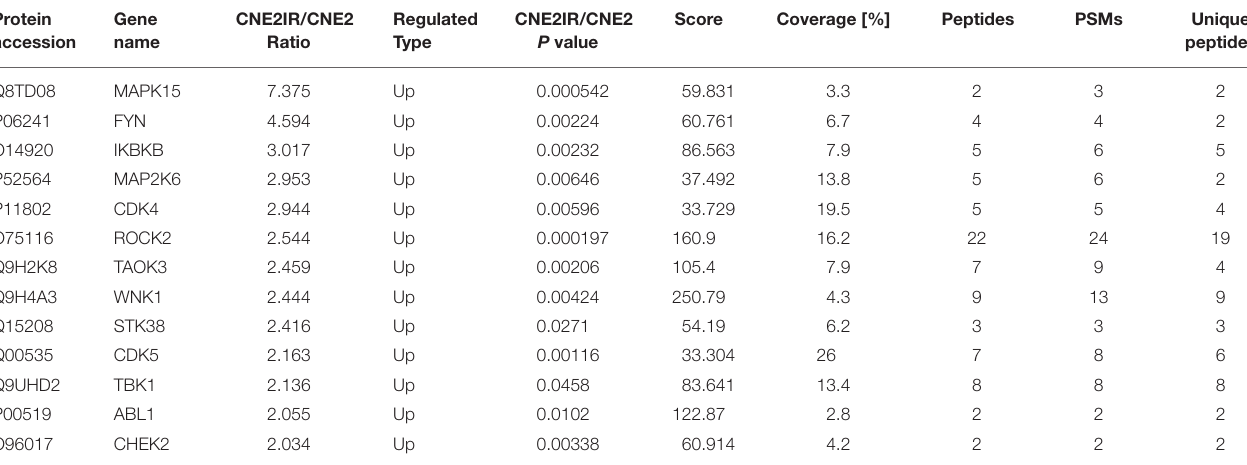
TABLE 1 | Radioresistance-related proteins in CNE2-IR cells. Protein